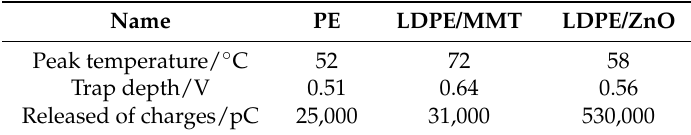
Figure 11. TSC spectra of samples. Table 4. Electron trap parameters.